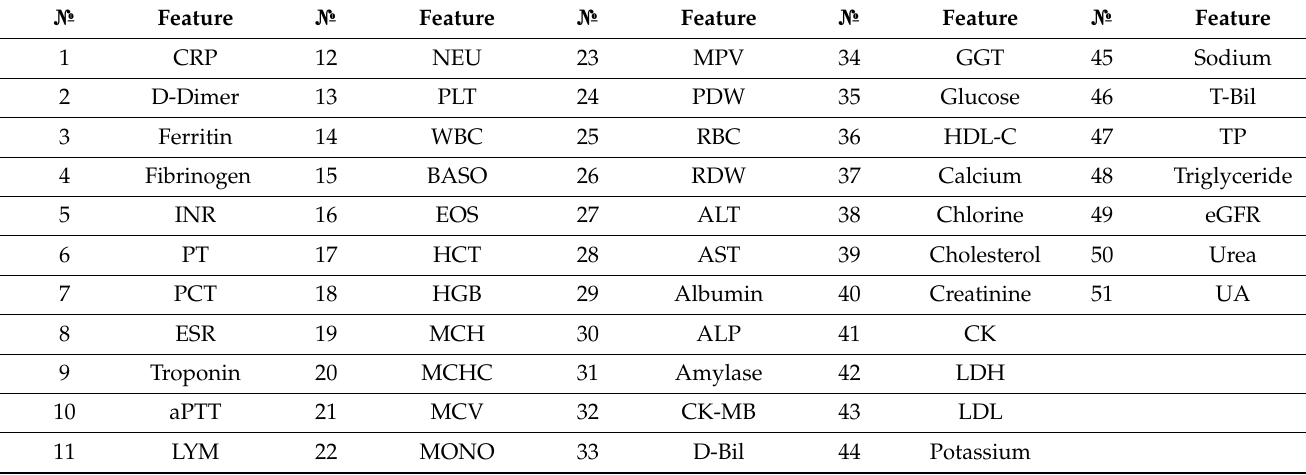
Table 1. Feature numbering for SARS-CoV-2-RBV1 dataset